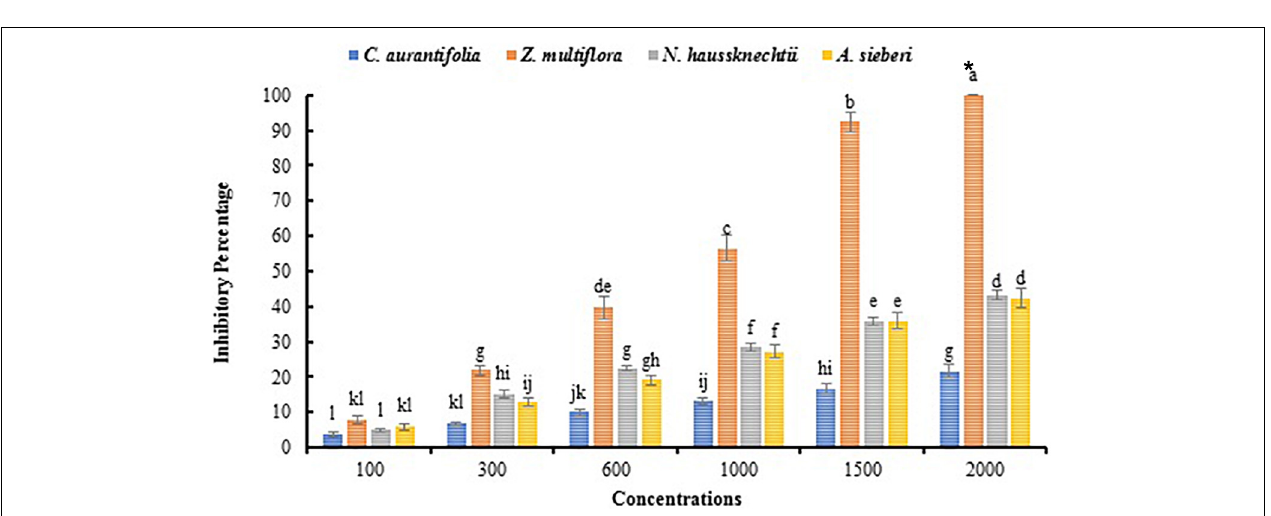
FIGURE 2 | Antifungal activity of EOs and nanocapsules on the growth rate of A. solani at various concentrations of 0–2,000 ppm: (A) Z. multiflora , (B) ZnO-ZmEO, (C) N. haussknechtii , (D) ZnO-NhEO, (E) A. sieberi , (F) ZnO-AsEO, (G) C. aurantifolia , and (H) ZnO-CaEO.